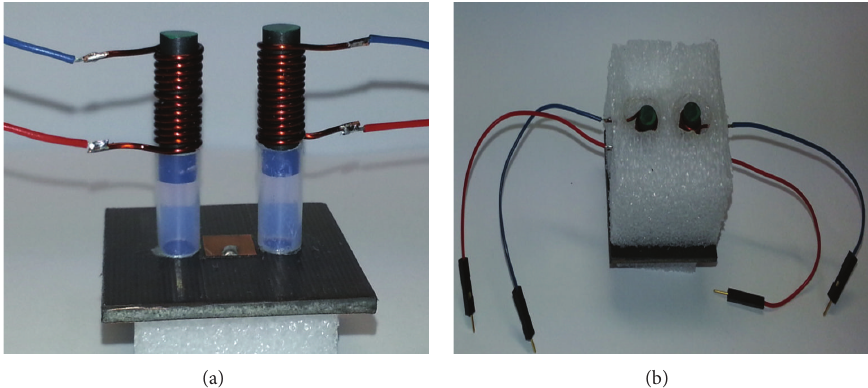
Figure 8: Fabricated 10GHzMPA loaded with ferrite rods, (a) ferrite rods with biasing coils and (b) with Styrofoam packing.